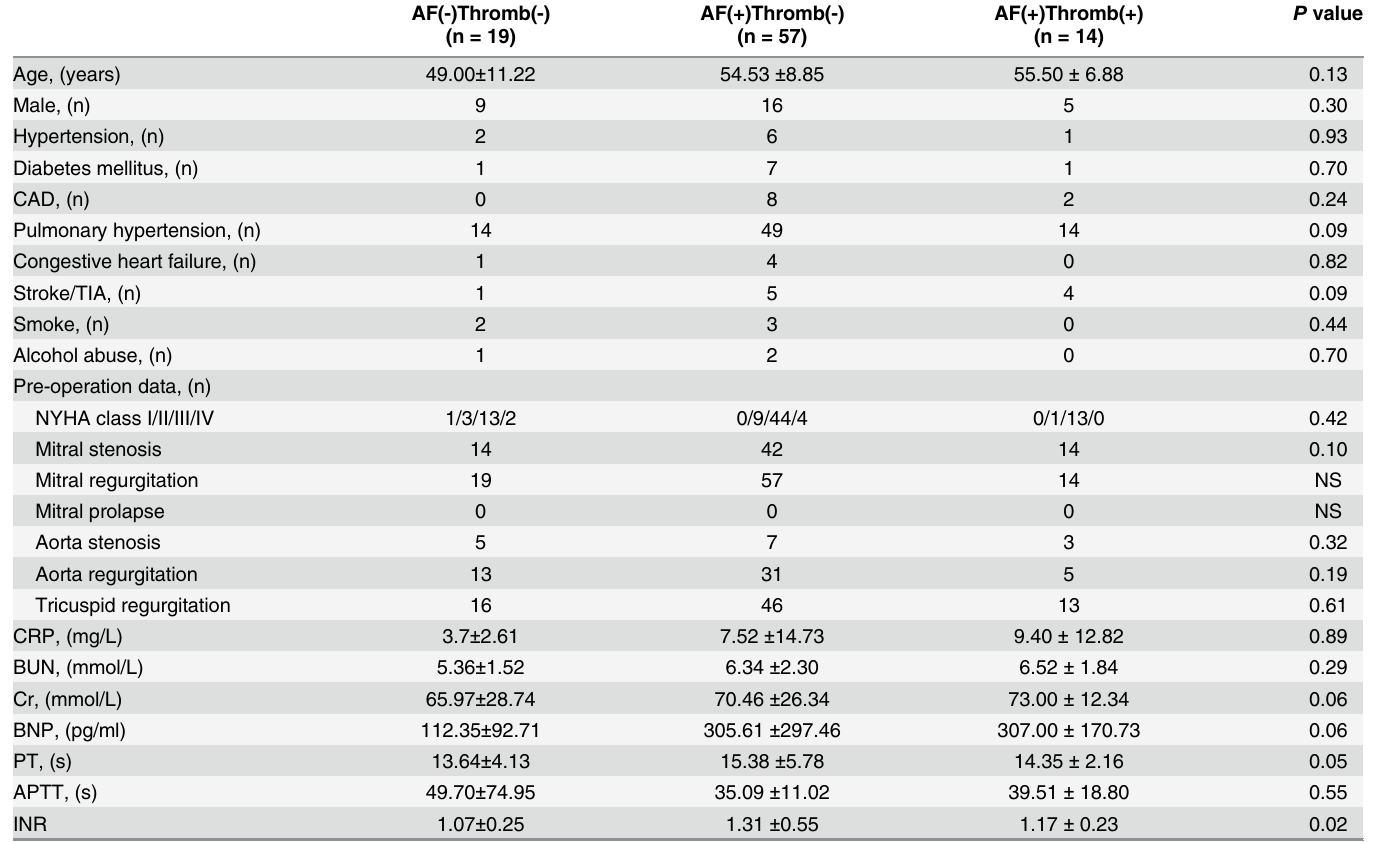
Table 1. Clinical